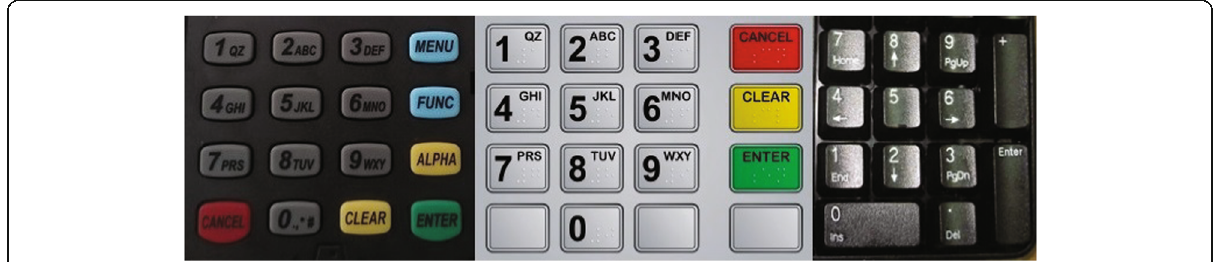
Fig. 7 Three kinds of keypad: keypad of POS terminal (left), keypad of ATM (middle), keypad on keyboard